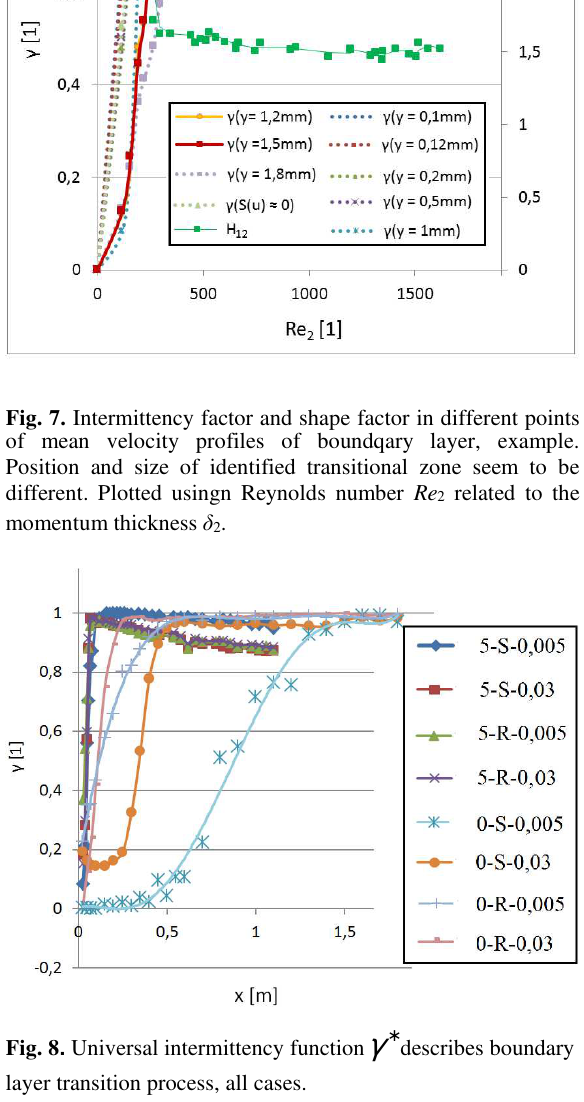
Fig. 8 . Universal intermittency function layer transition process, all cases.